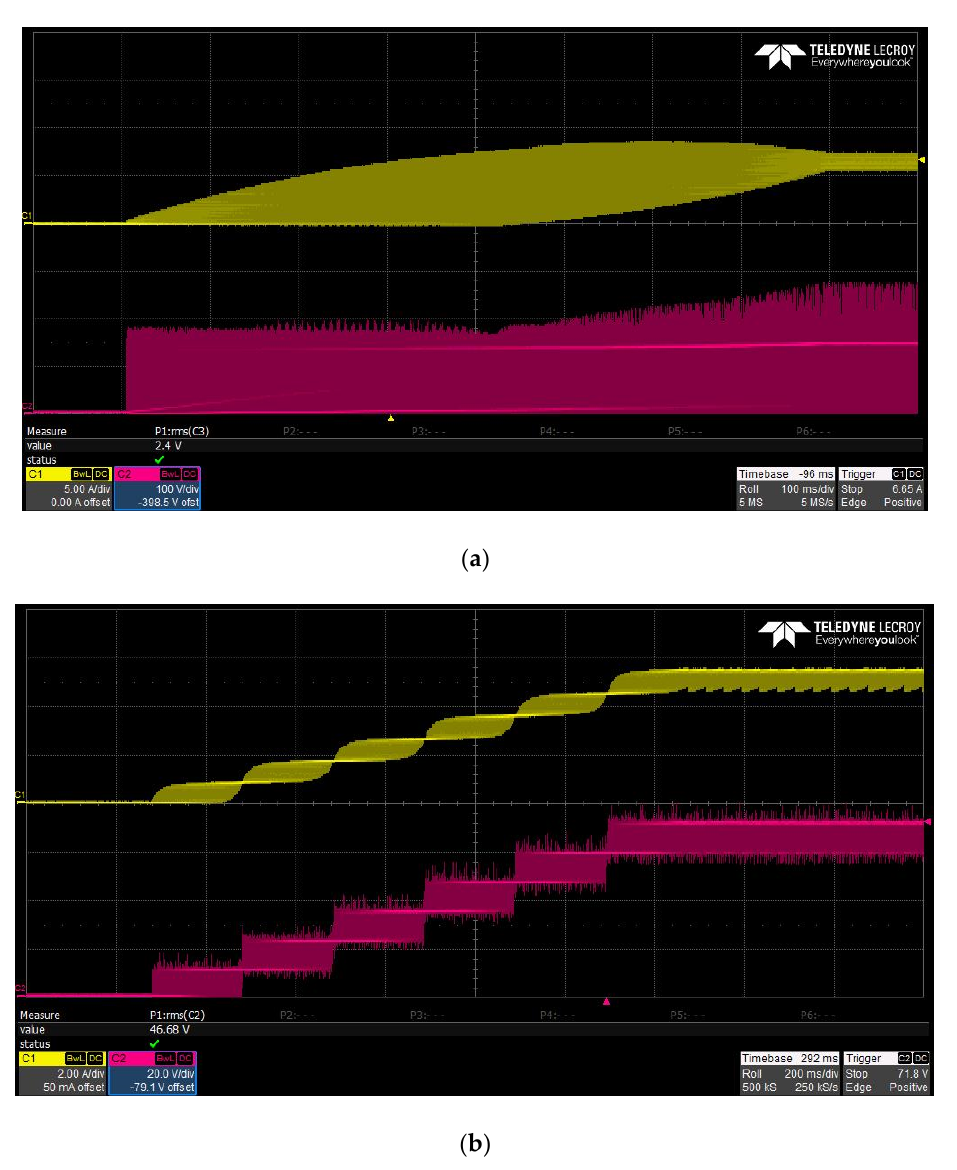
Figure 16. Current ripples of the reactor and voltage waveforms obtained by PWM for the ( a ) buck converter and ( b ) DPS-MLC.